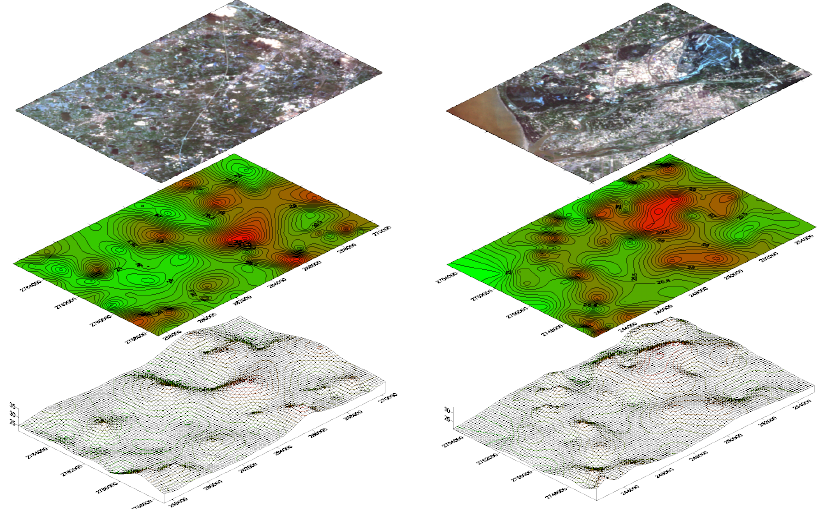
Figure 6. Taoyuan ( Right ) and Hsinchu ( Left ) research area satellite surface images and regional isothermal line maps, 28 May